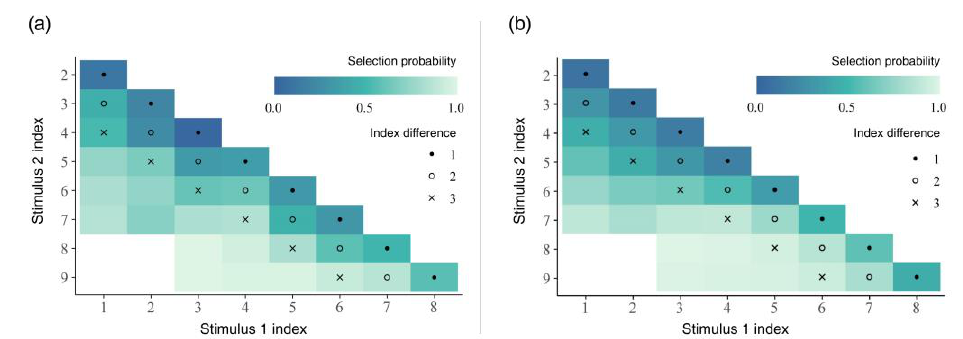
Figure 2. The original data before MLDS analysis. ( a ) shows the original data of the Real group. ( b ) shows the data of the Virtual group. The glossiness intensity (index number) of the stimuli is sorted from low to high. The different color brightness in the figure represents the probability of subjects choosing the stimulus pair composed of horizontal and vertical coordinate intensities. Different marker represents the index number difference between different stimulus pairs.